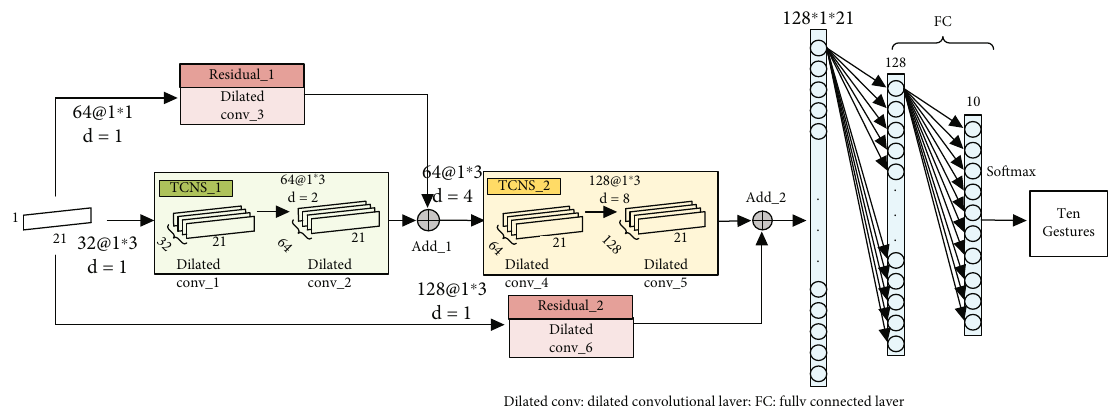
Figure 7: The TCNS architecture.